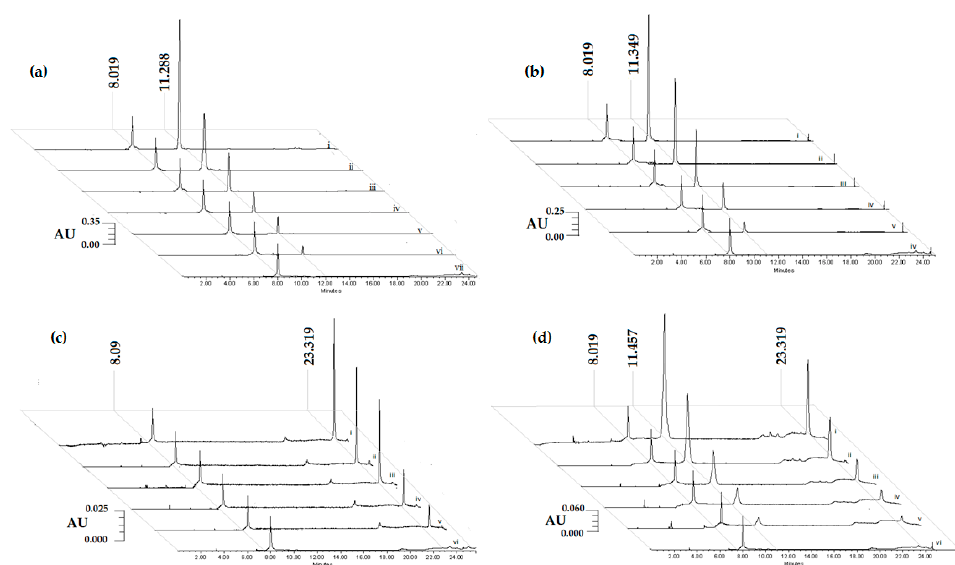
Figure 2. Chromatographic profiles of the concentration curves of tomentin ( a ), scopoletin ( b ), and sphaeralcic acid ( c ) pure active compounds, and SaTSS standardized fraction ( d ) obtained from Sphaeralcea angustifolia cell suspensions with the internal dopamine standard (rt = 8.019 min).